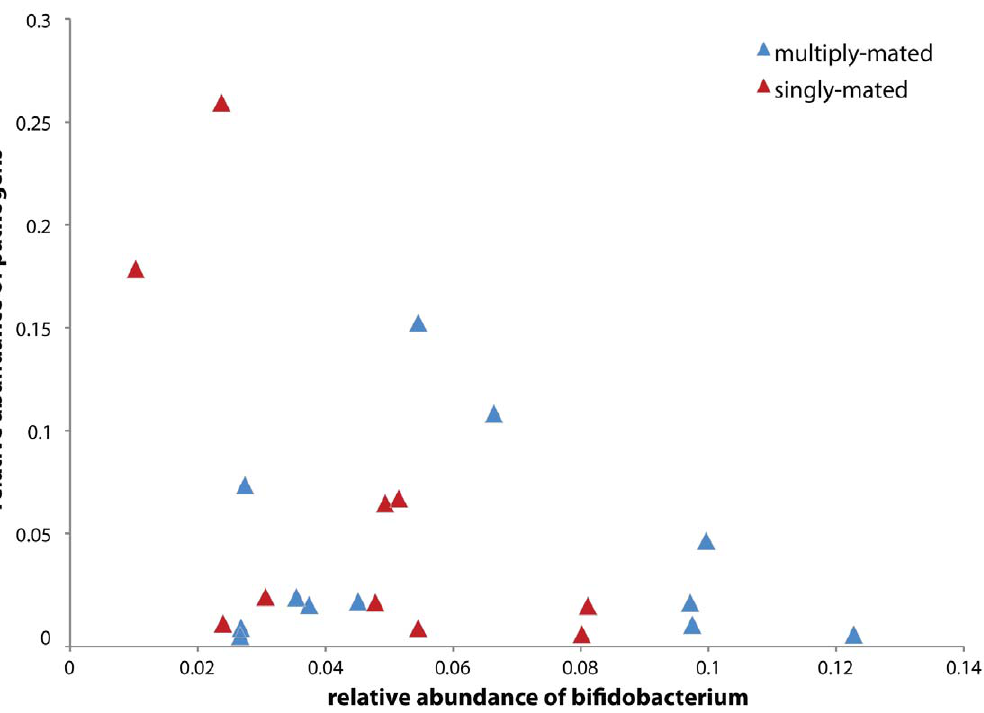
Figure 3. Relationship between Bifidobacterium and putative pathogens in the Mattila et al. (2012) dataset. Putative pathogens include Enterobacteriaceae and a known larval pathogen, Melissococcus plutonius .